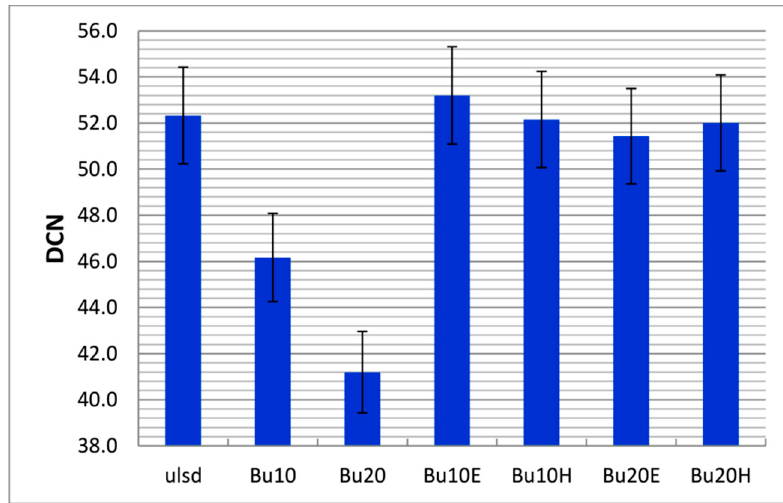
Figure 4. Measured DCN values of blends studied.